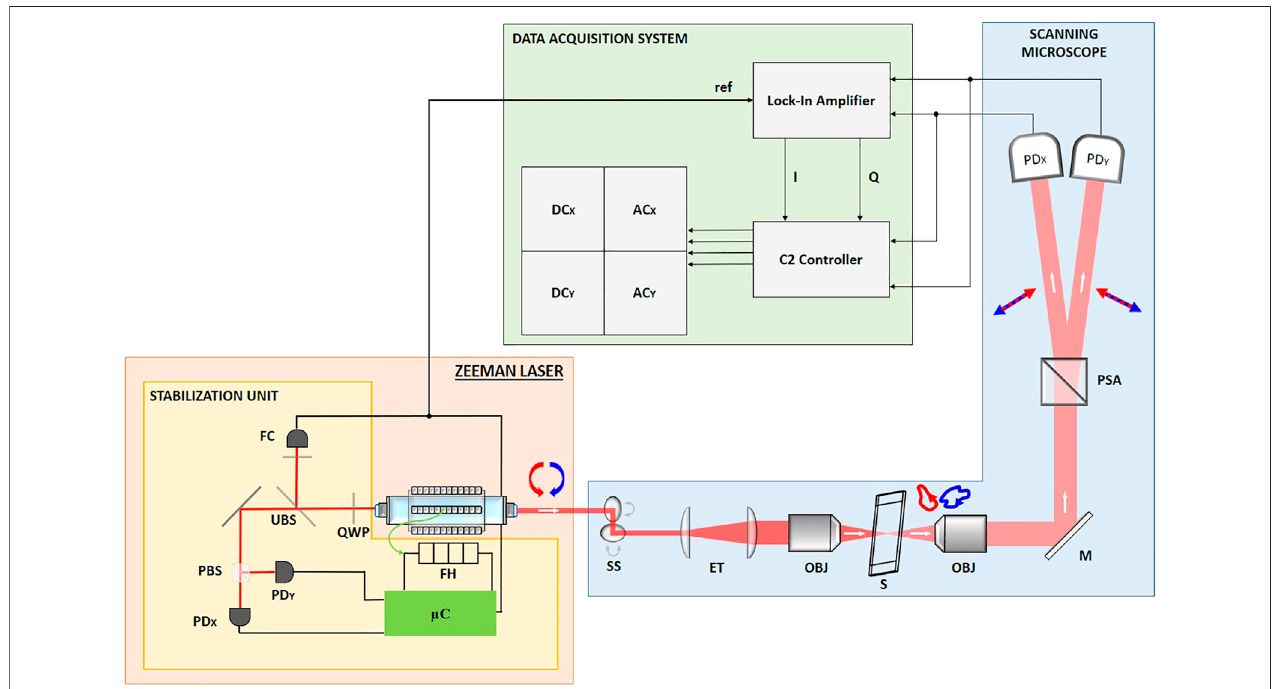
FIGURE 1 | Scheme of the microscopy setup shined by the ZL. The white arrows represent the direction of the beam, whereas the red and blue arrows are describing the polarization states. The main output of the ZL travels through a Scanning Stage (SS), an Expanding Telescope (ET), excitation and detection objectives (obj) in between which the sample (S) is placed. Finally, the polarization is split by the Wollaston Prism (acting as PSA) and detected by means of two fast photodiodes (PD X and PD Y